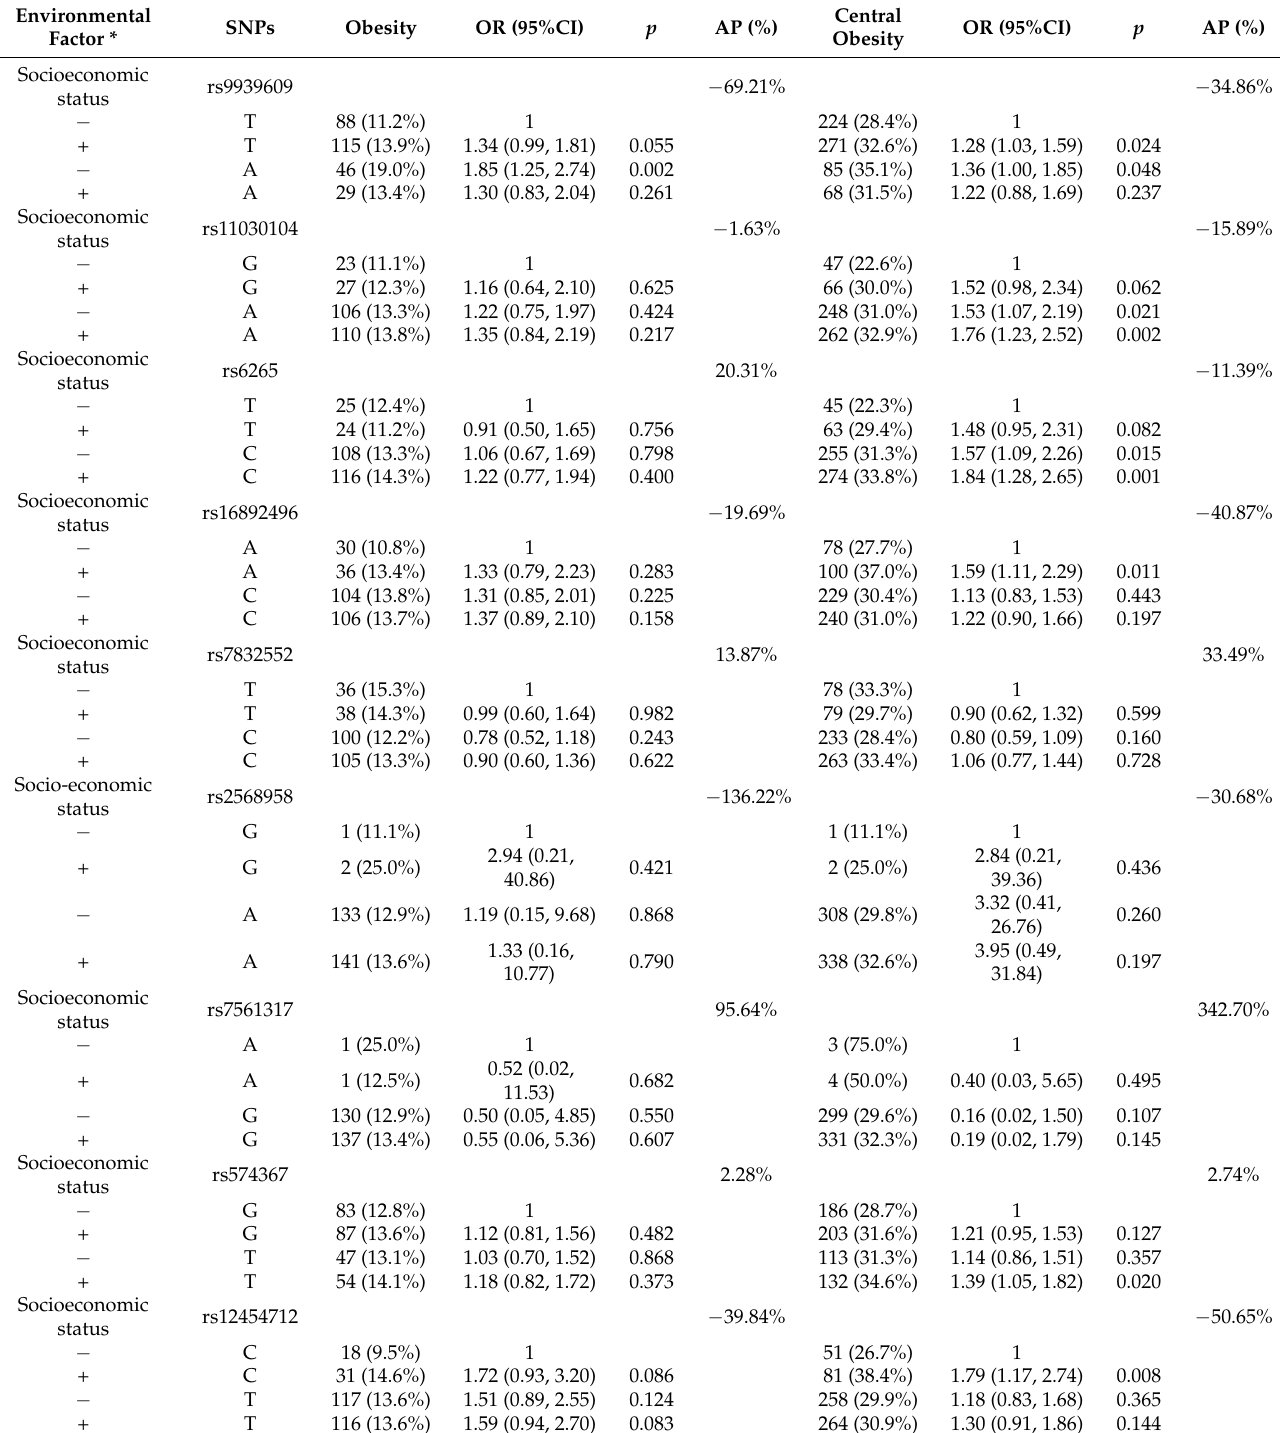
Table 5. The interaction between socioeconomic status and SNPs in obesity and central